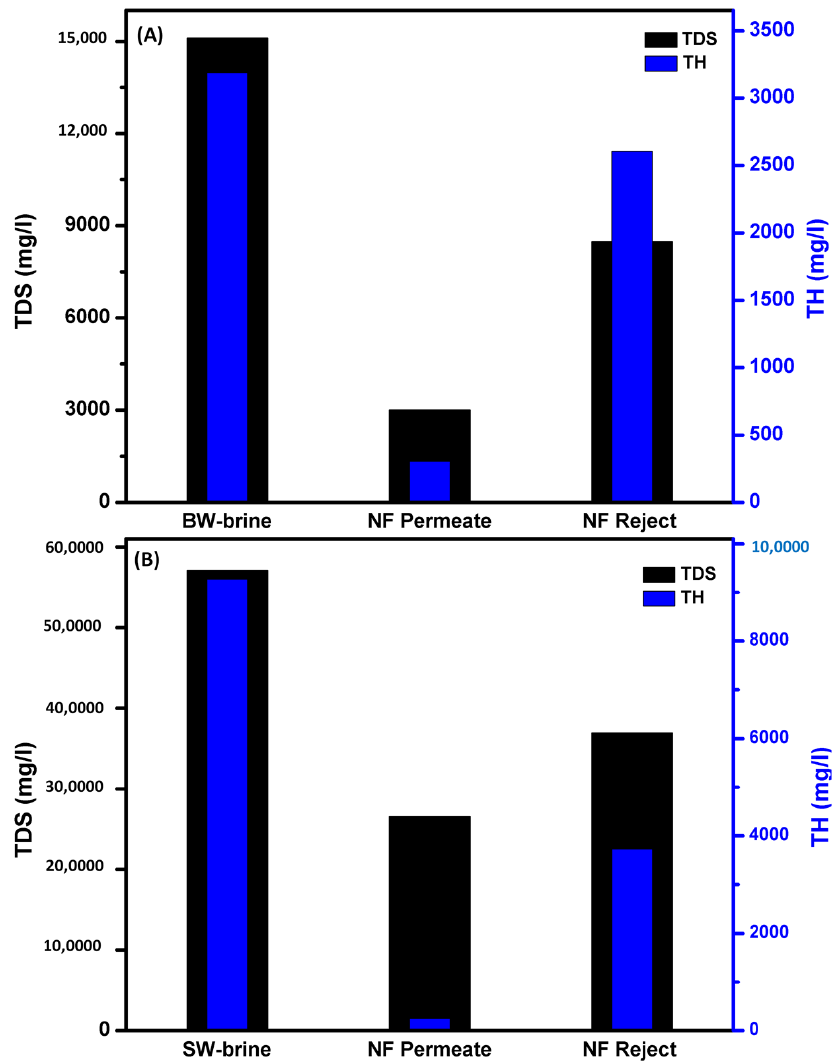
Figure 2. Total dissolved salts and total hardness removal percentages using the membrane of ( A ) Brackish water, and ( B ) Sea water. operating conditions: pressure 0.7 MPa, operation time 8 h, operation temperature, 25 °C & flow rate, 5 L/min.